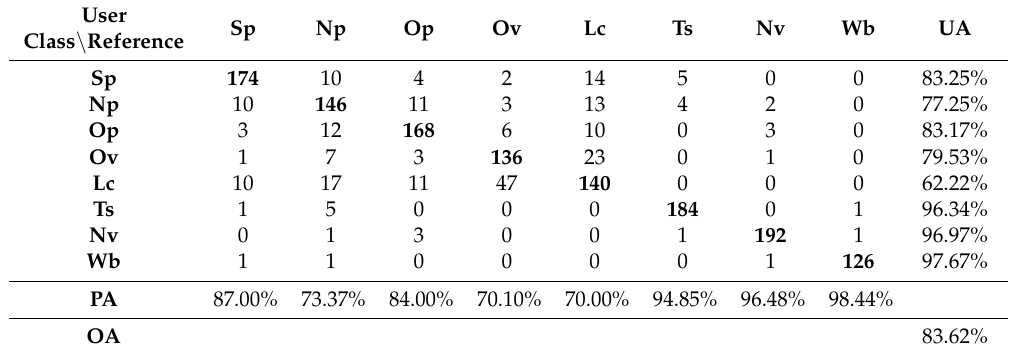
Table 4. Confusion matrices between classified image and reference data for the ten most important